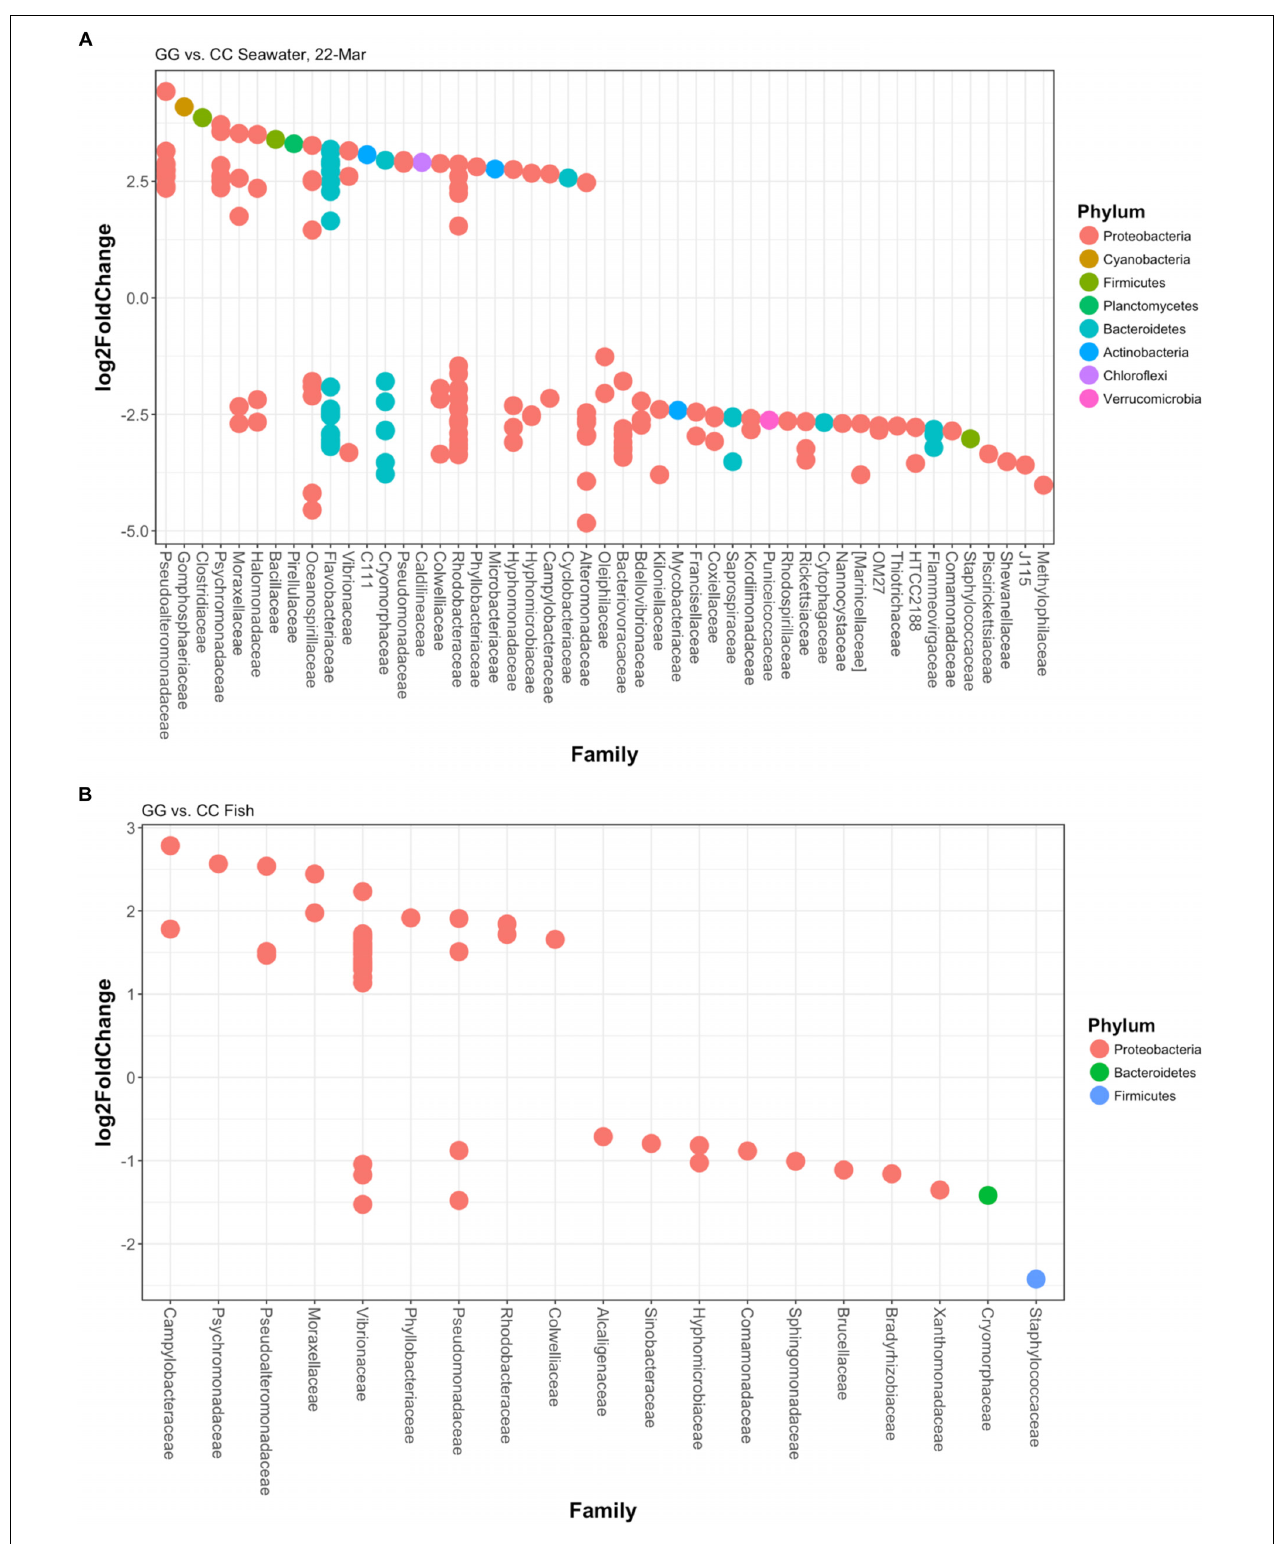
FIGURE 5 | Log 2 fold changes in OTUs found in (A) greenwater compared to claywater on the final sampling date and (B) whole fish in the greenwater treatment compared to whole fish in the claywater treatment from all timepoints of the experiment. Each dot represents a different OTU. Colors designate the phylum each OTU belongs to, and their associated family is on the x -axis. All are significant ( p < 0.05) using DESEq2’s built-in Benjamini–Hochberg correction for adjusted p